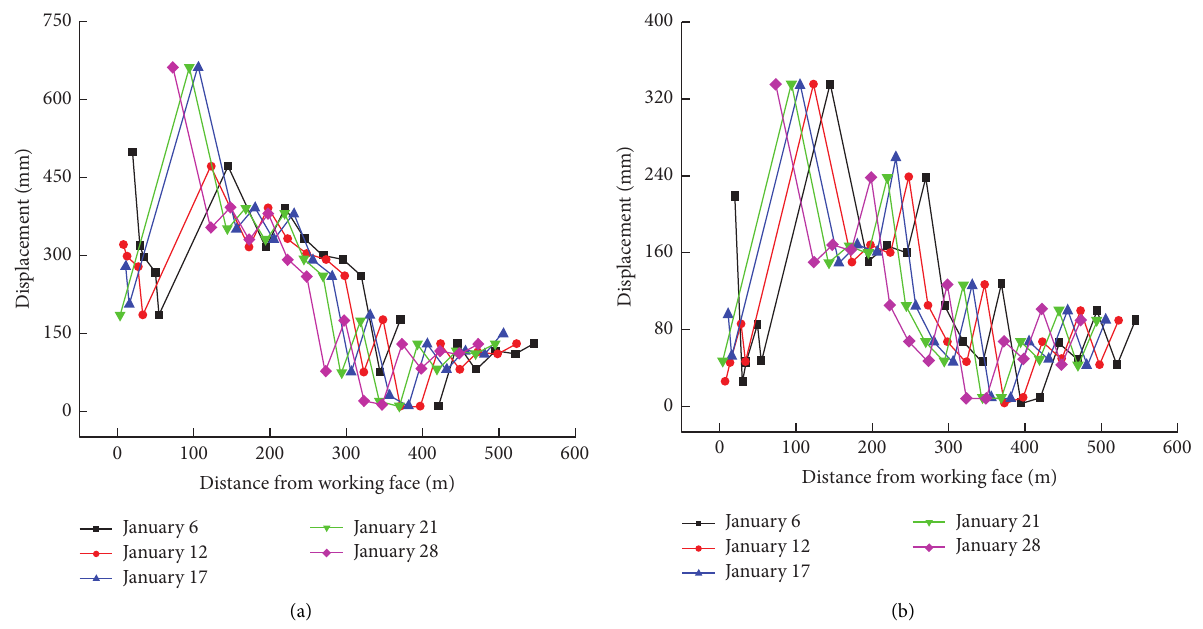
Figure 16: Deformation data from the return air roadway. (a) Roof and floor approach. (b) Two-sided approach.